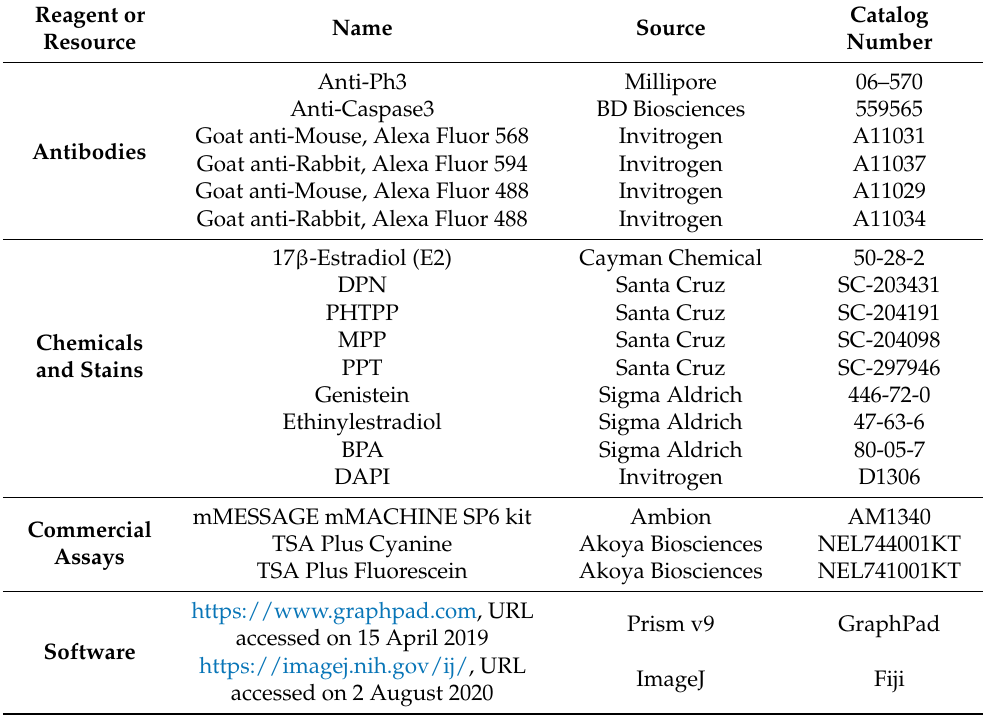
Table 1. Reagents and resources used in this